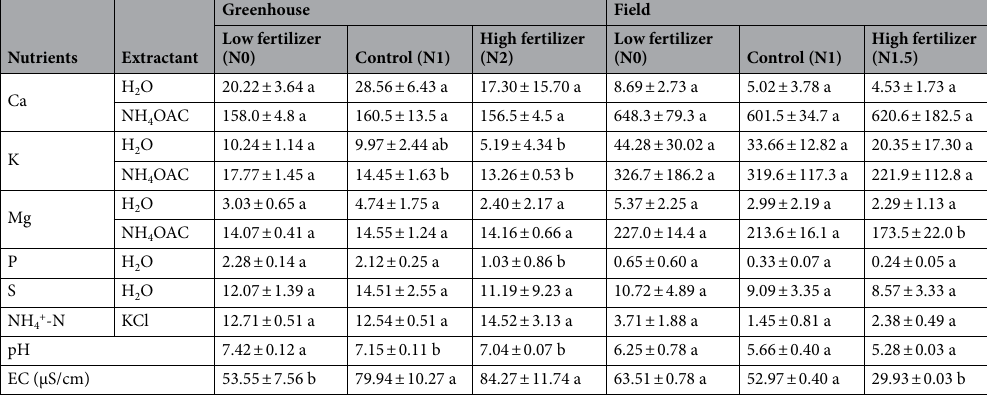
Table 4. Water and ammonium extractable nutrient concentrations of soils treated with different urea fertilizer (mg/kg). Significant differences among different treatment groups were marked with different letters ( p <